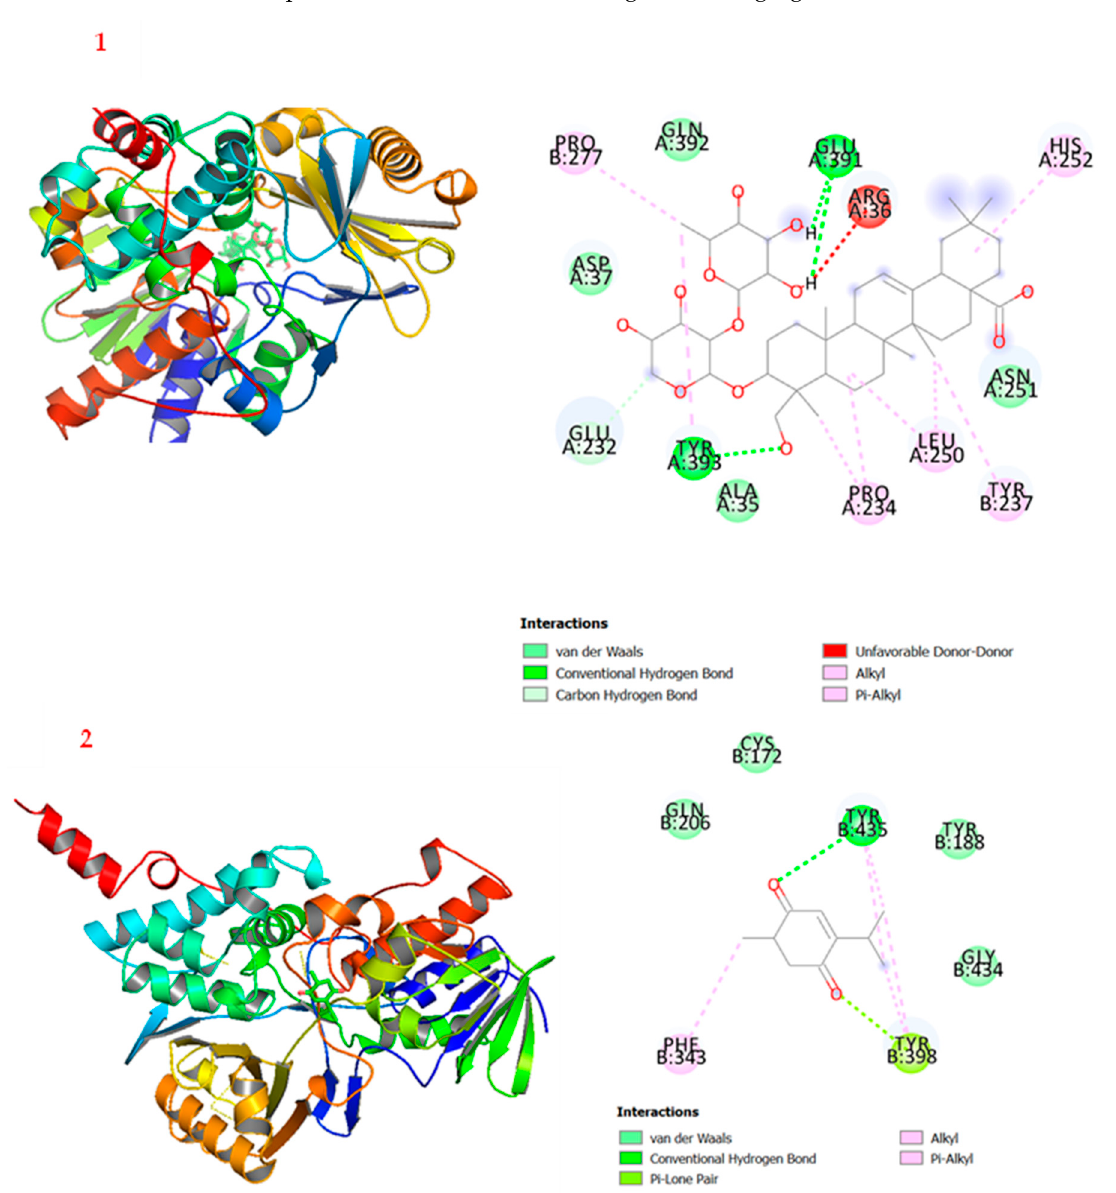
Figure 5. 2D and 3D interactions of MAO - B with ligands 1 and